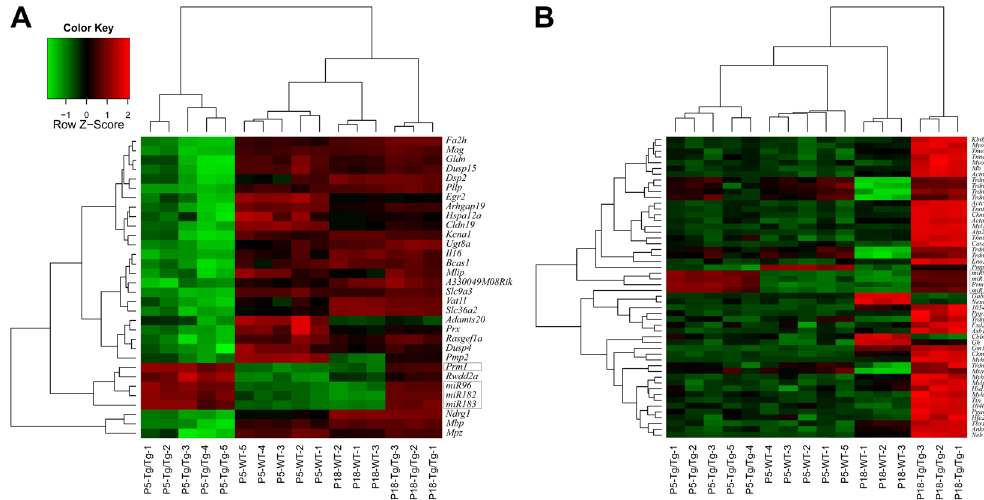
Figure 5. Clustered heatmaps of significantly changed genes in Tg 1MDW/1MDW Affymetrix microarray analysis. ( A ) OC-P5 heatmap showing normalized expression for 32 significantly changed genes found by two-way ANOVA (Age X Genotype, FDR-adjusted P < 0.05, fold change cutoff ± 2). ( B ) Cochlear-P18 heatmap of normalized expression for 52 probesets (45 genes) significantly changed in Tg 1MDW/1MDW (FDR-adjusted P < 0.05, fold change cutoff ± 2). Irrespective of age, the most upregulated Affymetrix probesets were genetic elements of Tg 1MDW : Mir183 , Mir96 , Mir182 and Prm1 (boxed